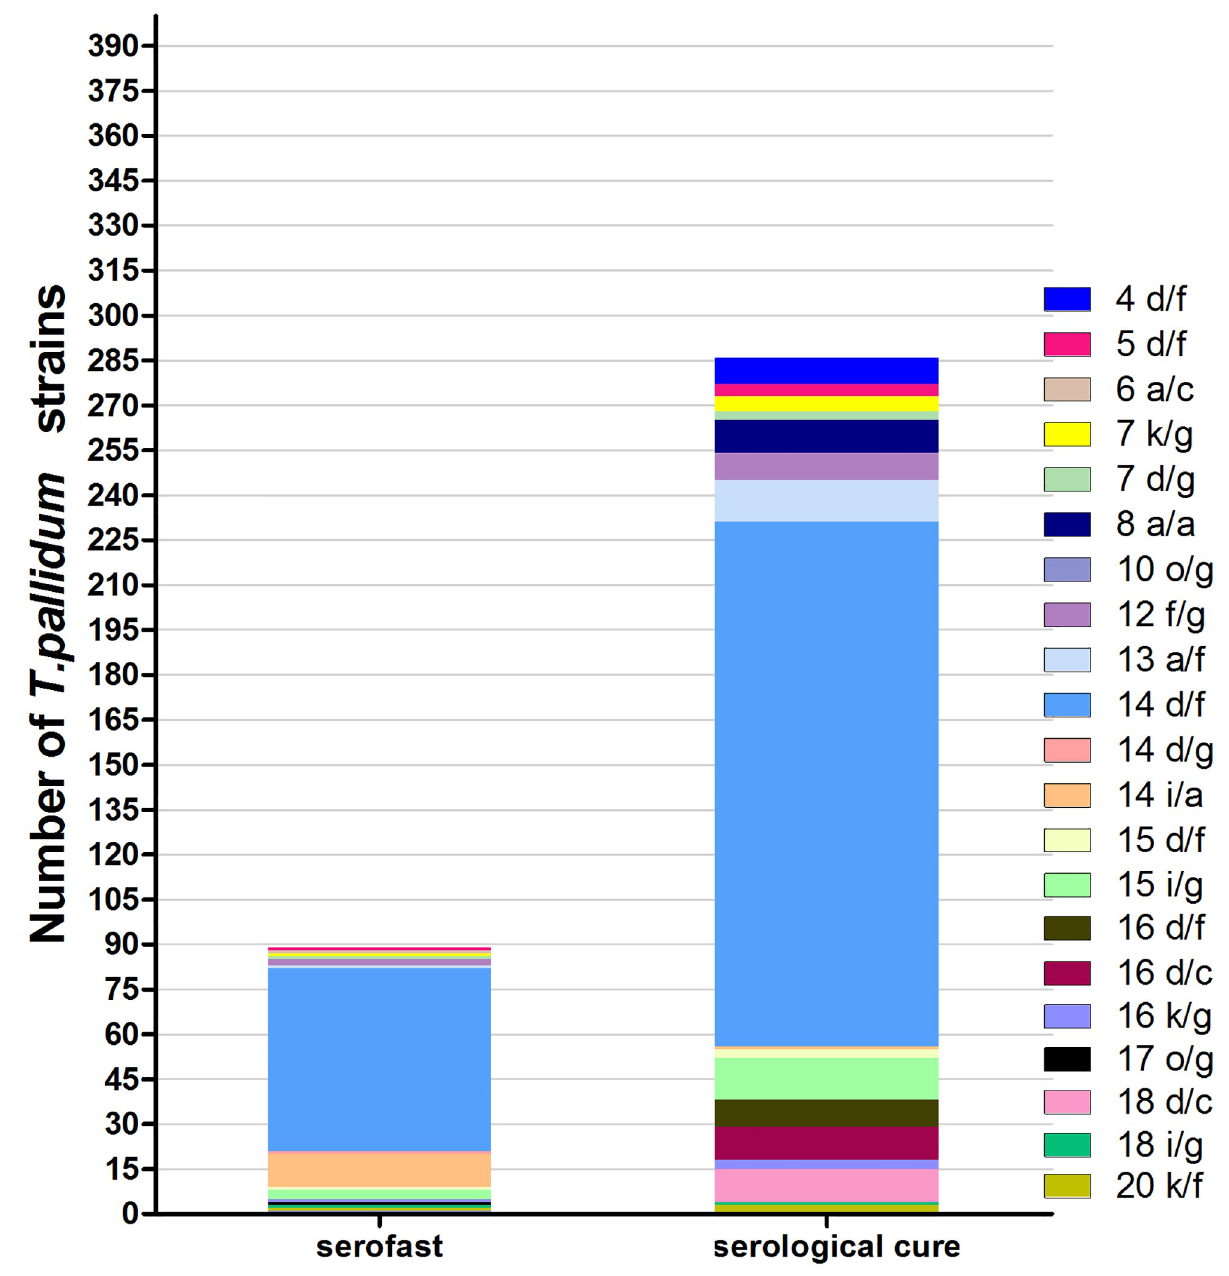
Fig 2. Distribution of T . pallidum strains isolated from serofast patients and serological cure patients, 2011 to 2015. The 14d/f type was the predominantsubtype in two groupspatients. The novel type of 14 i/a might predict an increasing risk of serofast status ( χ 2 = 34.4, P <